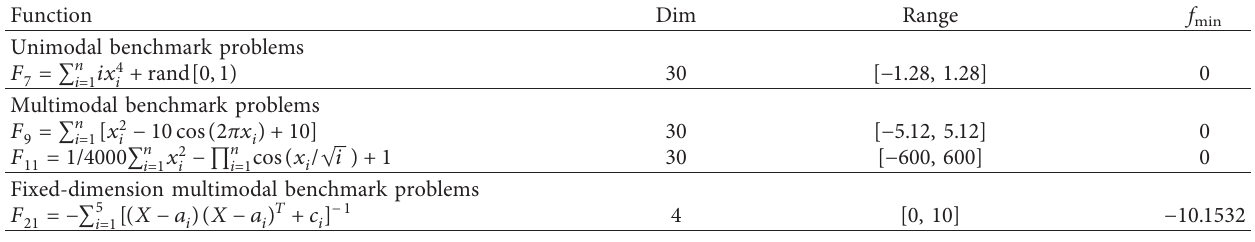
Table 1: Benchmark functions employed in this section.